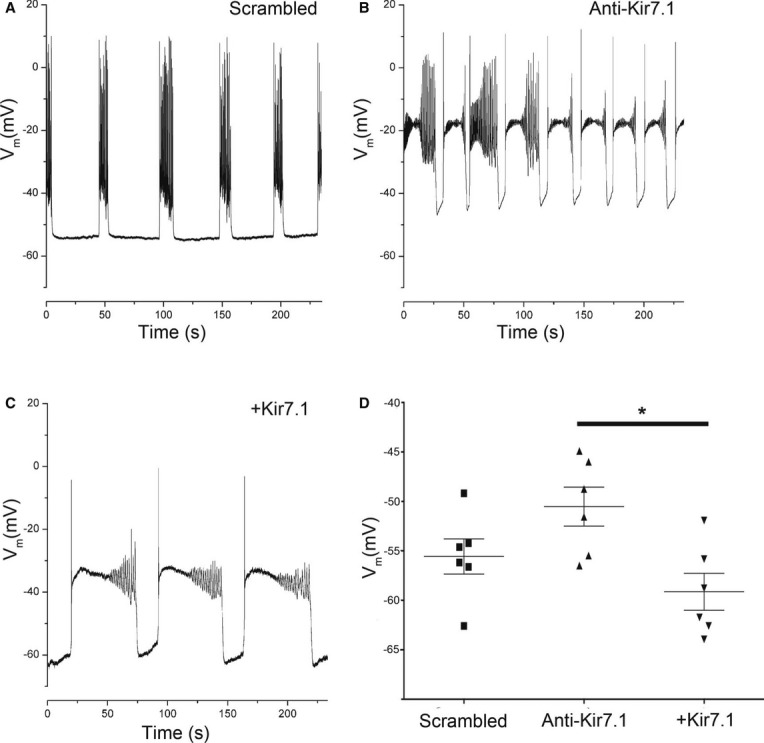
Knockdown of Kir7.1 in vitro depolarizes resting membrane potentialA–C Representative membrane potential recordings in current clamp configuration from murine myometrial strips (A) treated with scrambled control miRNA (B) treated with Kir7.1 knockdown (Anti-Kir7.1) and (C) overexpressing Kir7.1 (+Kir7.1).D Resting membrane potential in current clamp configuration from murine myometrial strips (n = 6; mean ± SD) from experiments depicted in (5A–C). *P < 0.05 by Student's t-test.